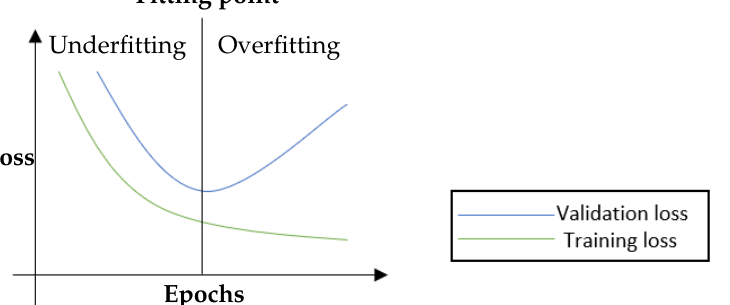
Figure 1. An illustration of the training and validation loss curves. Training and validation losses decrease simultaneously until the fitting point. After that, the validation loss begins to rise while the training loss is still decreasing, i.e., the so-called overfitting. Overfitting is associated with good performance on the training data but poor generalisation to the validation/test data (cf. underfitting is associated with poor performance on the training data and poor generalisation to the validation data) [12].